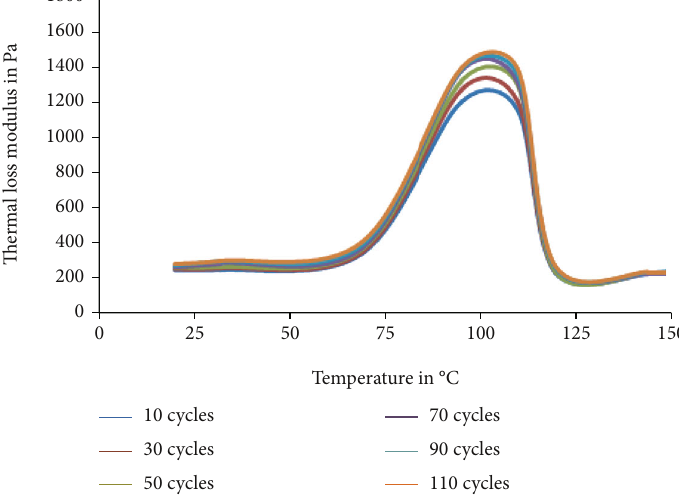
Figure 5: Thermal loss modulus of epoxy